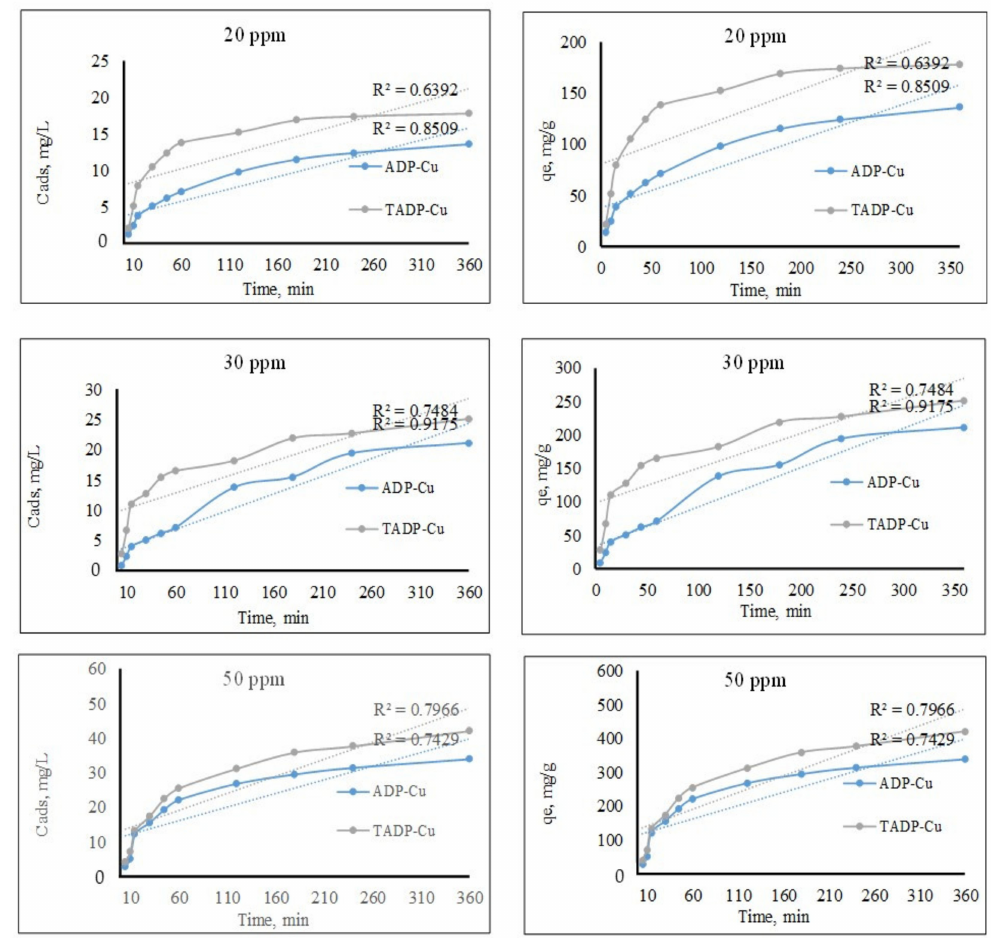
Figure 8. Effect of contact time at concentrations 20, 30, and 50 mg/L of the adsorbates (experimental conditions: Co: 25 mg/L; m: 0.005 g; V: 0.05 L; T: 25 ◦ C; agitation speed: 100